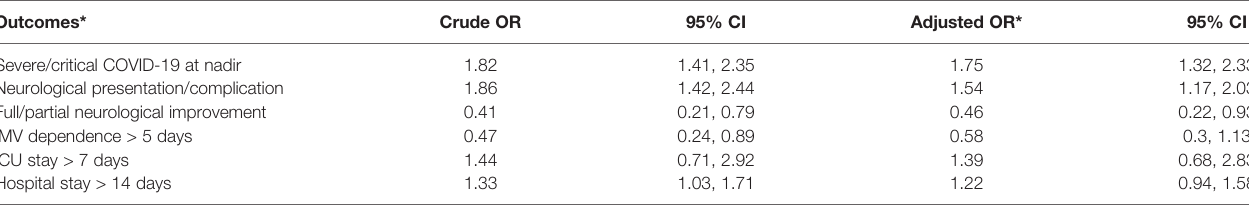
TABLE 3 | Association of having a cancer with the different outcomes of interest. Outcomes* Crude OR 95% CI Adjusted OR* 95% CI Severe/critical COVID-19 at